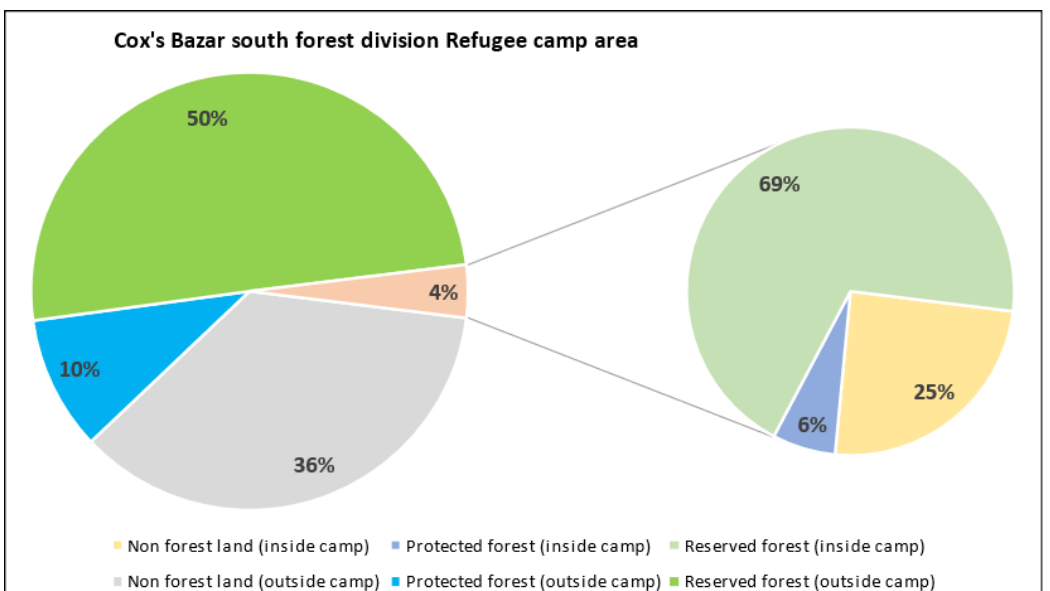
Figure 3. Distribution of forest land area with Cox’s Bazar south forest division and refugee camp area.